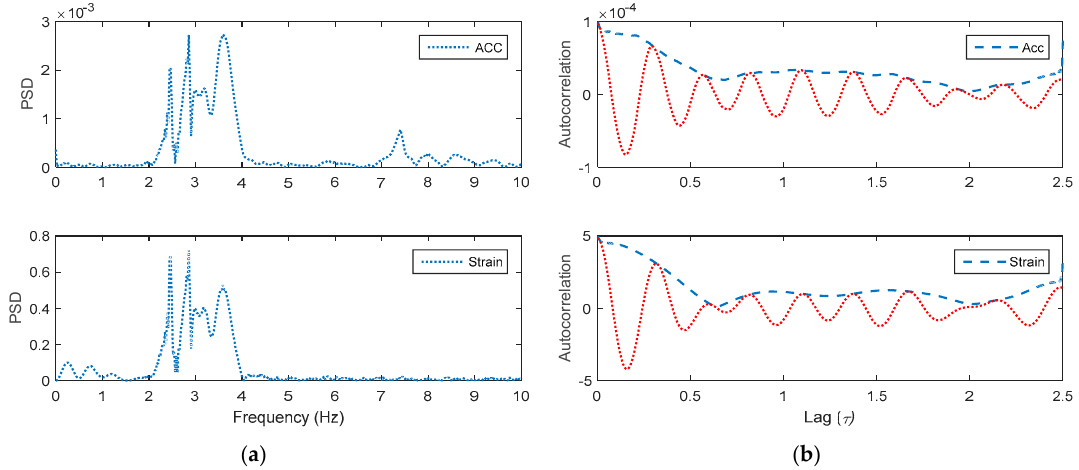
Figure 12. ( a ) Frequency and ( b ) damping ratio of the bridge with a 40 km / h truck speed.